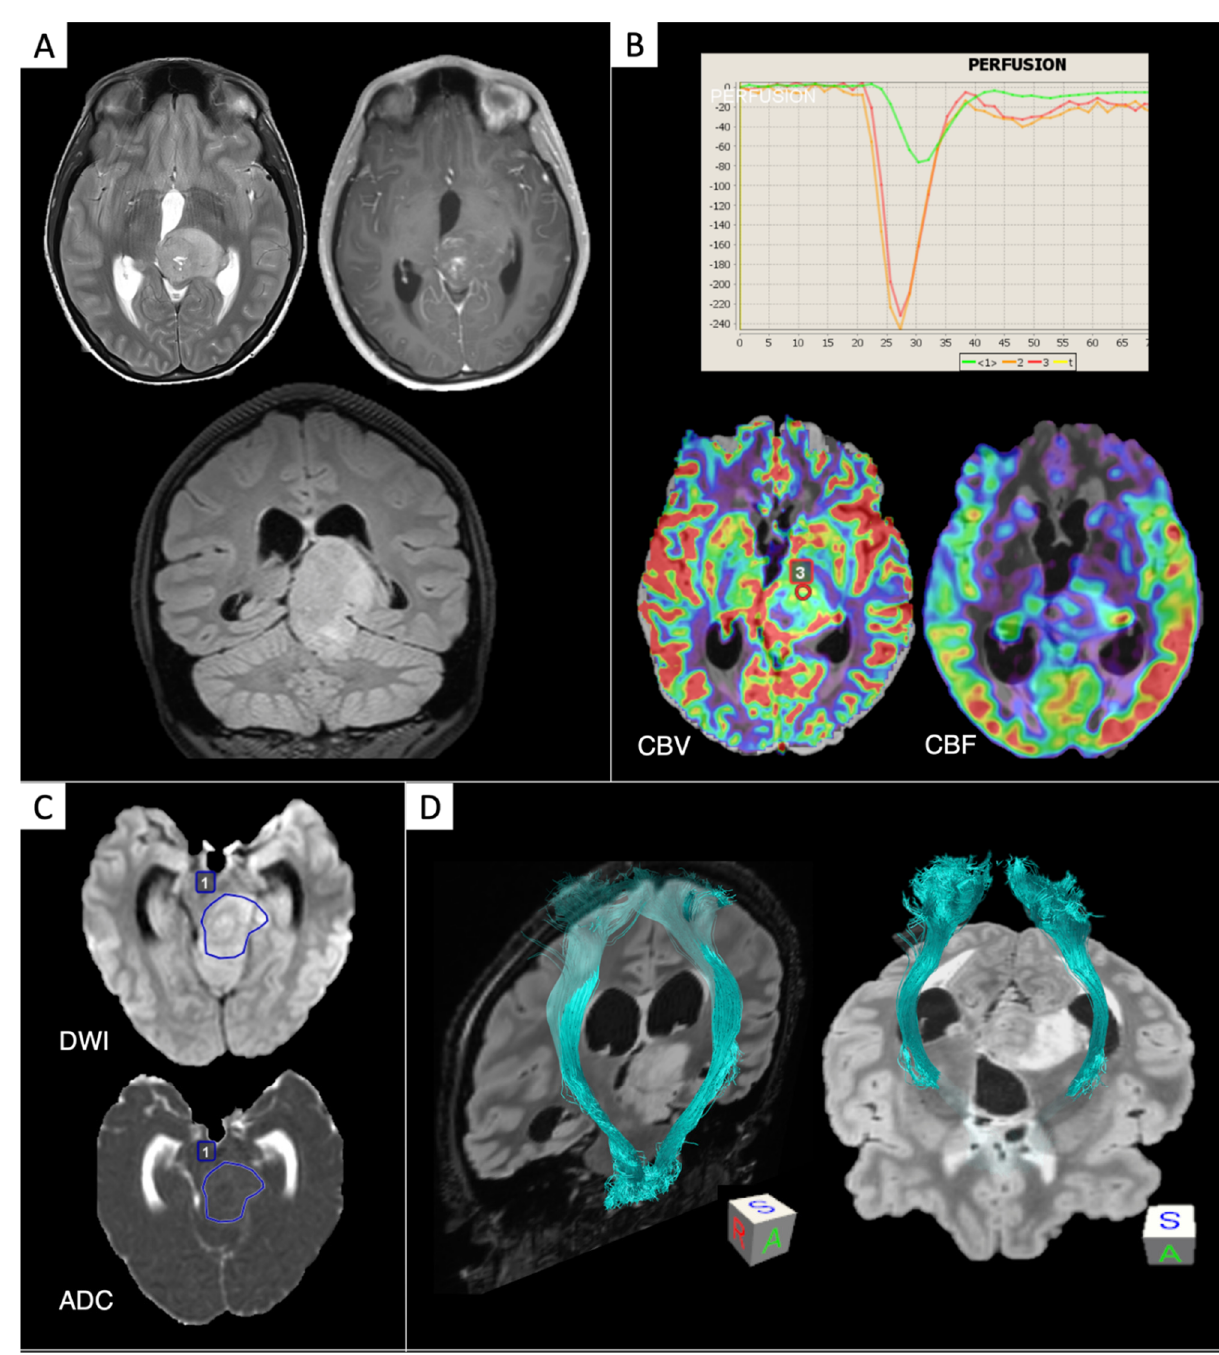
Figure 3. Diffuse midline glioma H3K27M mut . MRI datasets were retrieved from the archive of our Institution. ( A ) Conventional MRI (cMRI): T2, contrast-enhanced T1, FLAIR (coronal section). ( B ) PWI: dynamic susceptibility contrast (DSC) curve (red and orange: tumor ROIs; green: NAWM), DSC-cerebral blood volume (CBV) (red: tumor ROI), arterial spin labeling (ASL)-cerebral blood flow (CBF). DSC “hotspot” ROI evaluation revealed “aggressive” perfusion features (red ROI: CBV max , 4 mL/100 g; CBV max /CBV NAWM , 6.48); ASL-CBF showed highly perfused spots within the tumor tissue. ( C ) dMRI: a clinically feasible single-slice ROI evaluation revealed low diffusion parameters (blue ROI: ADC mean , 0.87 mm 2 /s; ADC mean /ADC NAWM ratio, 1.19). ( D ) Q-ball tractography of corticospinal tracts, exhibiting a mild ventrolateral dislocation of the left tract due to the mass effect of the lesion.